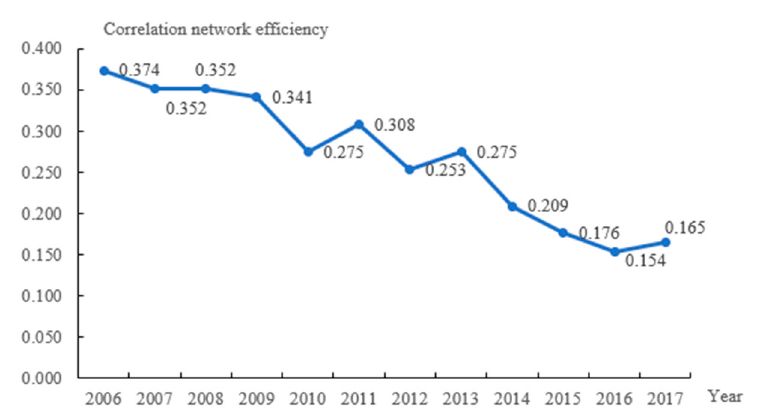
Figure 5. Correlation network efficiency of Yangtze River Delta’s water environmental governance in 2006–2017.